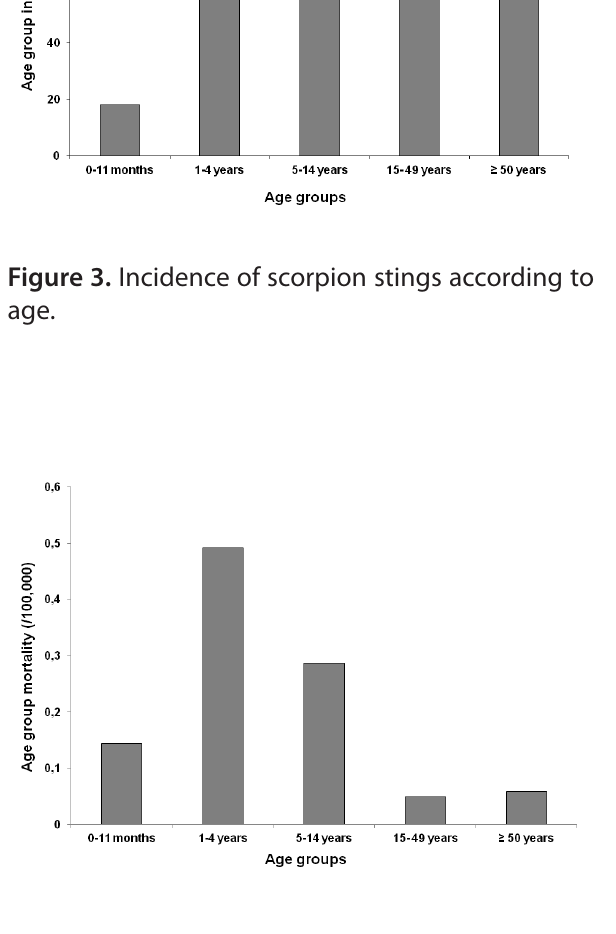
Figure 4. Mortality due to scorpion stings according to age.